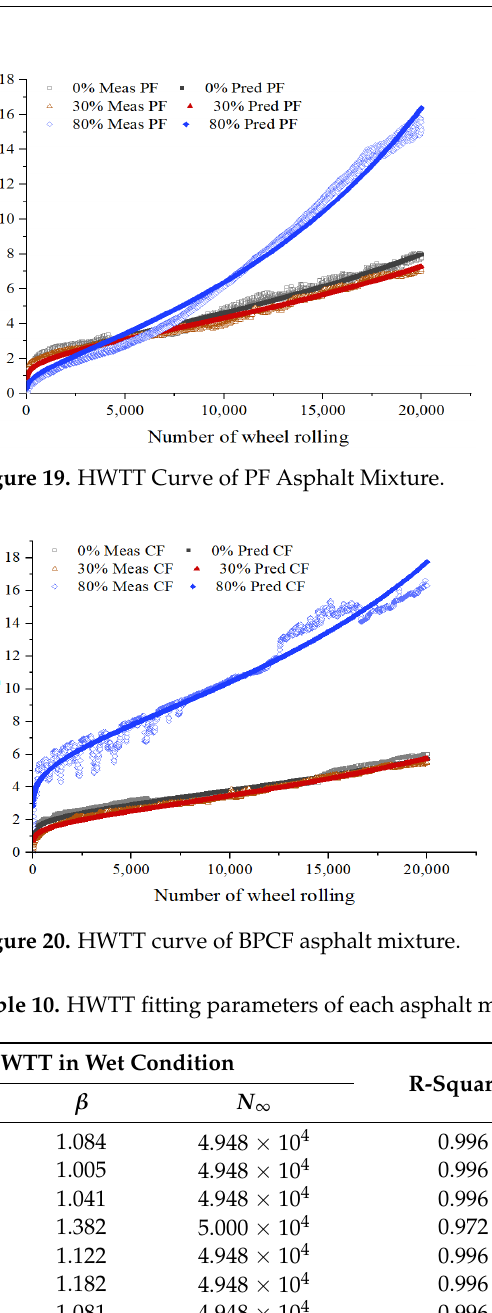
Figure 18. HWTT curve of LF asphalt mixture.